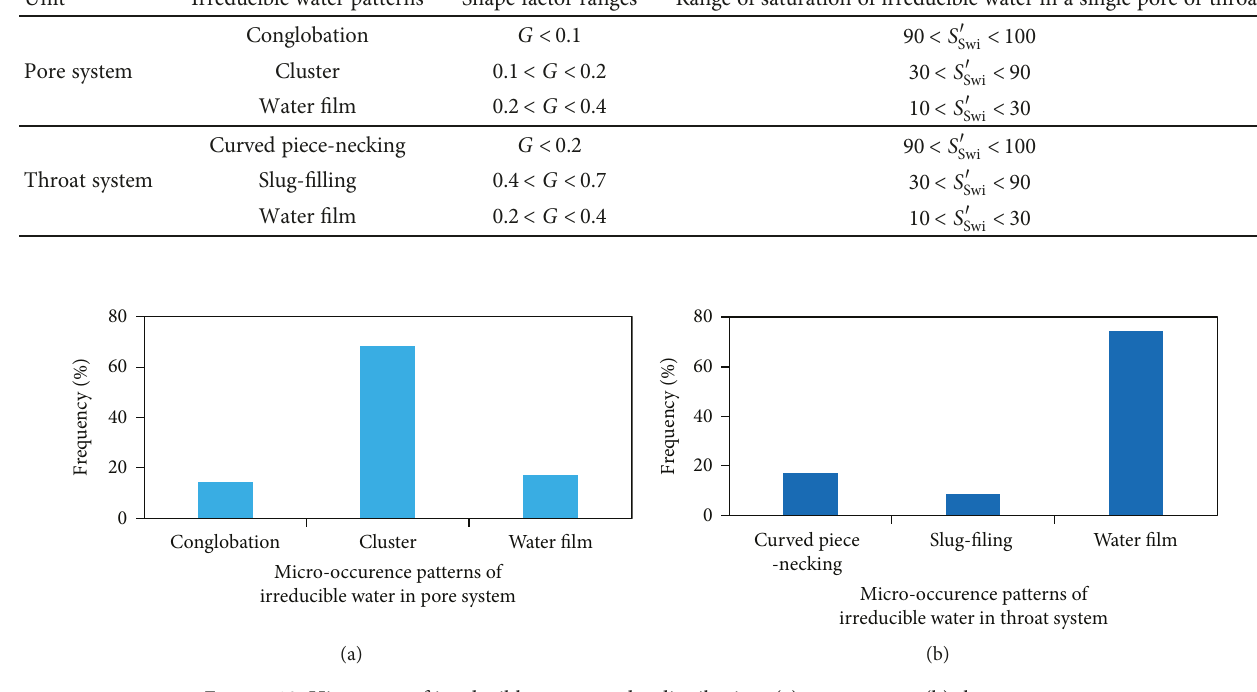
Figure 18: Histogram of irreducible water modes distribution: (a) pore system; (b) throat